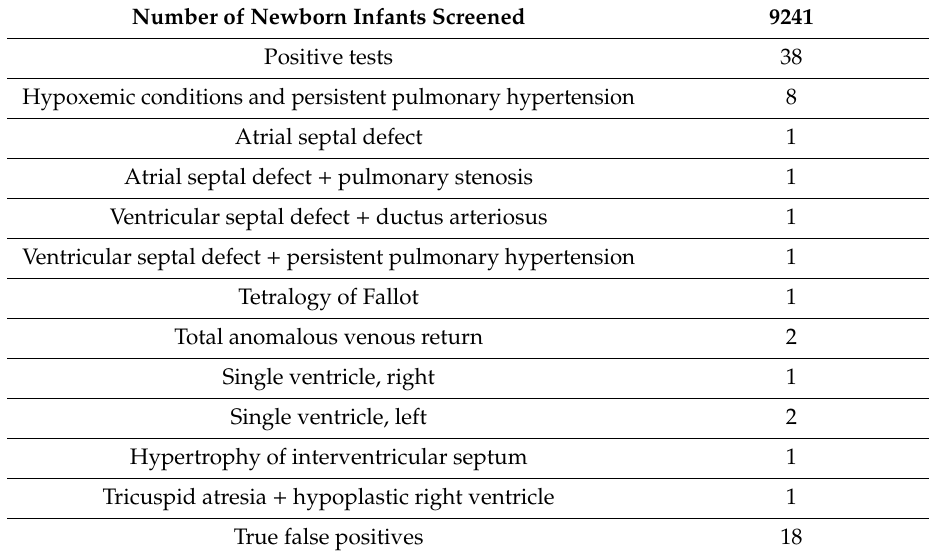
Table 1. Results of pulse oximetry screening (POS) at Hospital Niño Jes ú s in Barranquilla,